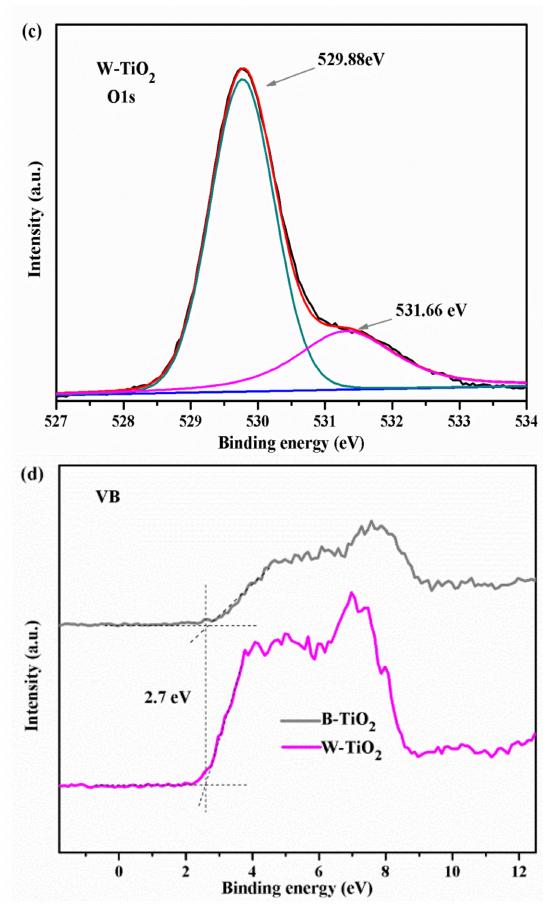
Figure 5. ( a ) The Ti 2p XPS spectra for the as-prepared B-TiO 2 and W-TiO 2 nanoparticles; ( b )The O